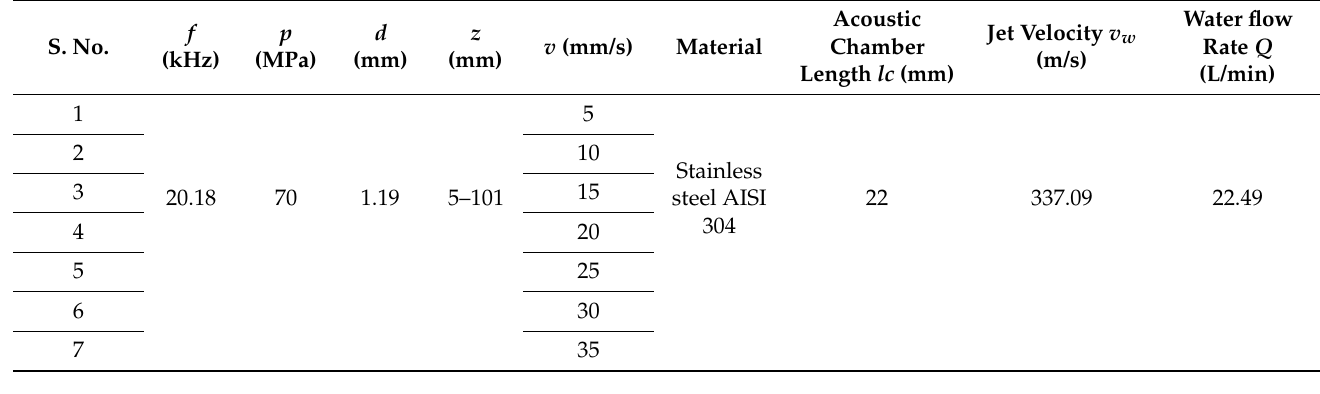
Table 4. Experimental conditions.